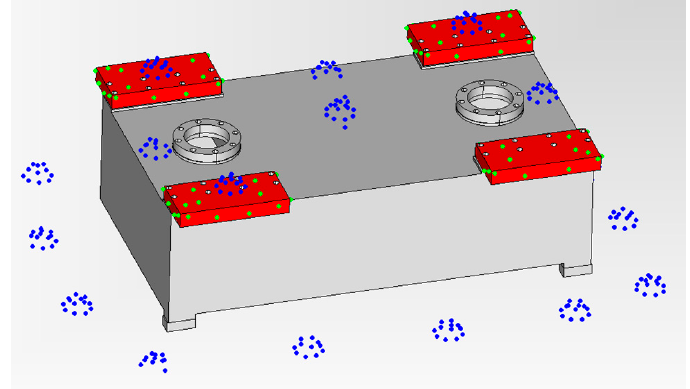
Figure 14. Fitting of non-coded target coordinates (green) to nominal reference surfaces on CAD file (red) for evaluating measuring error, along with auxiliary multicoded targets in the scene (blue).